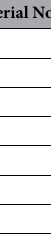
Table 1. Grid free analysis for the Sherwood number.